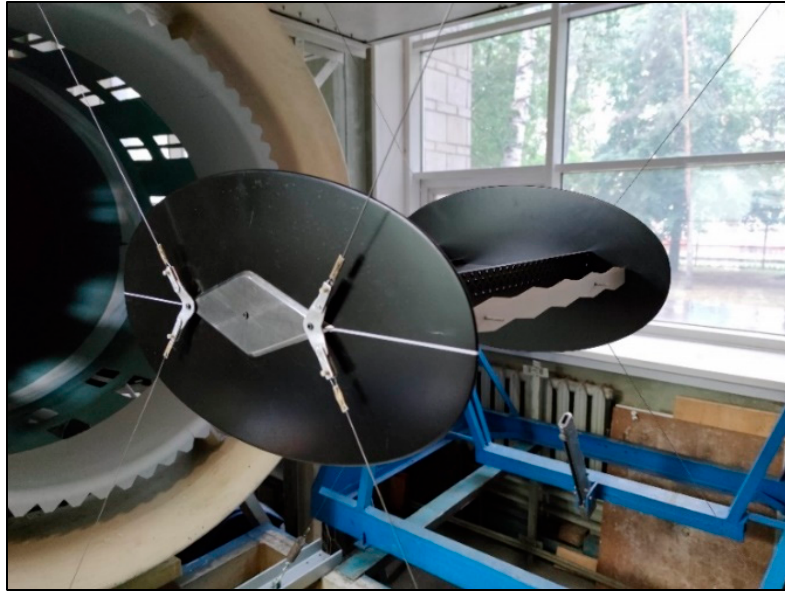
Figure 6. The sectional models on the elastic suspension.